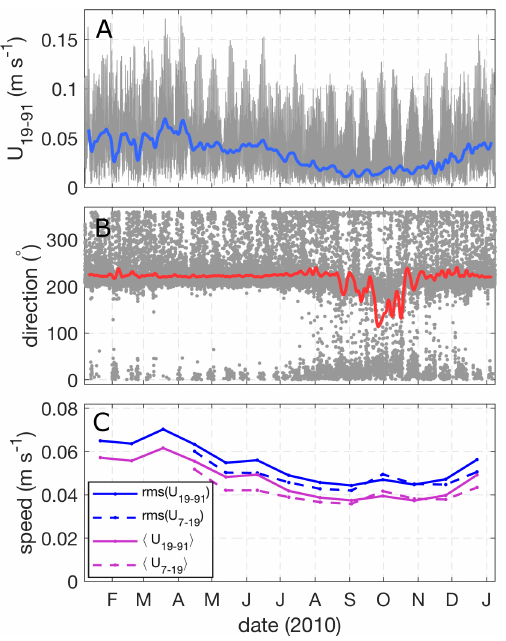
(cid:112) u 2 + v 2 from 19– Figure 6. (a) Depth-mean current speed U = 91m below the ice (grey). Overlaid is the smoothed residual cur- rent speed ( U r , blue). (b) Current direction from north (grey) and smoothed residual current direction (red). (c) Monthly mean ( (cid:104) U (cid:105) ) and root-mean-square (rms( U )) current speed for depth ranges 7– 19 and 19–91m below the ice. Current speed data over the depth range 7–19m is not plotted for the months January–April due to poor data return near the ice during that